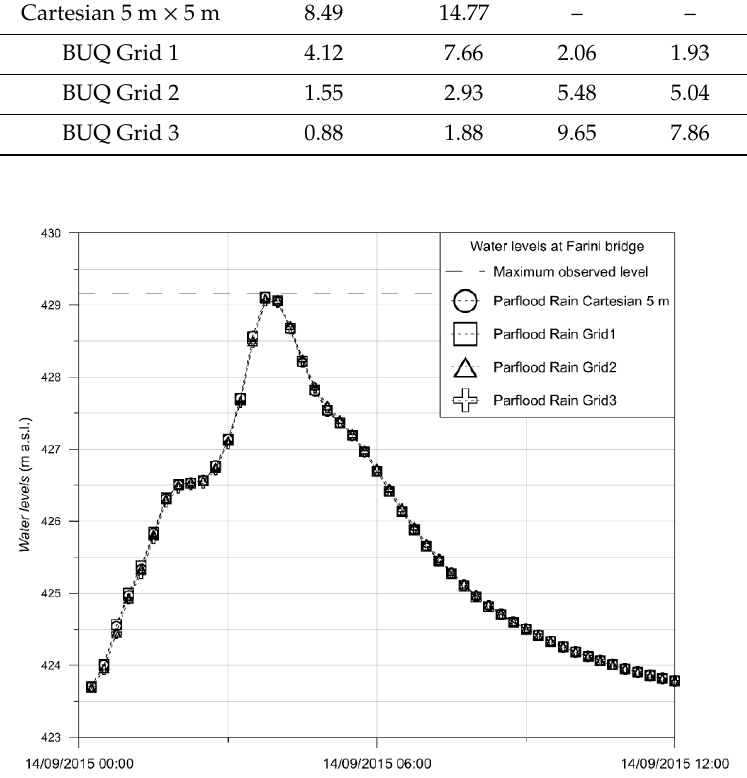
Figure 16. Water level hydrographs at the Farini bridge for the reference simulation, the multiresolution simulations (BUQ Grid 1, 2 and 3) and maximum water observed level.